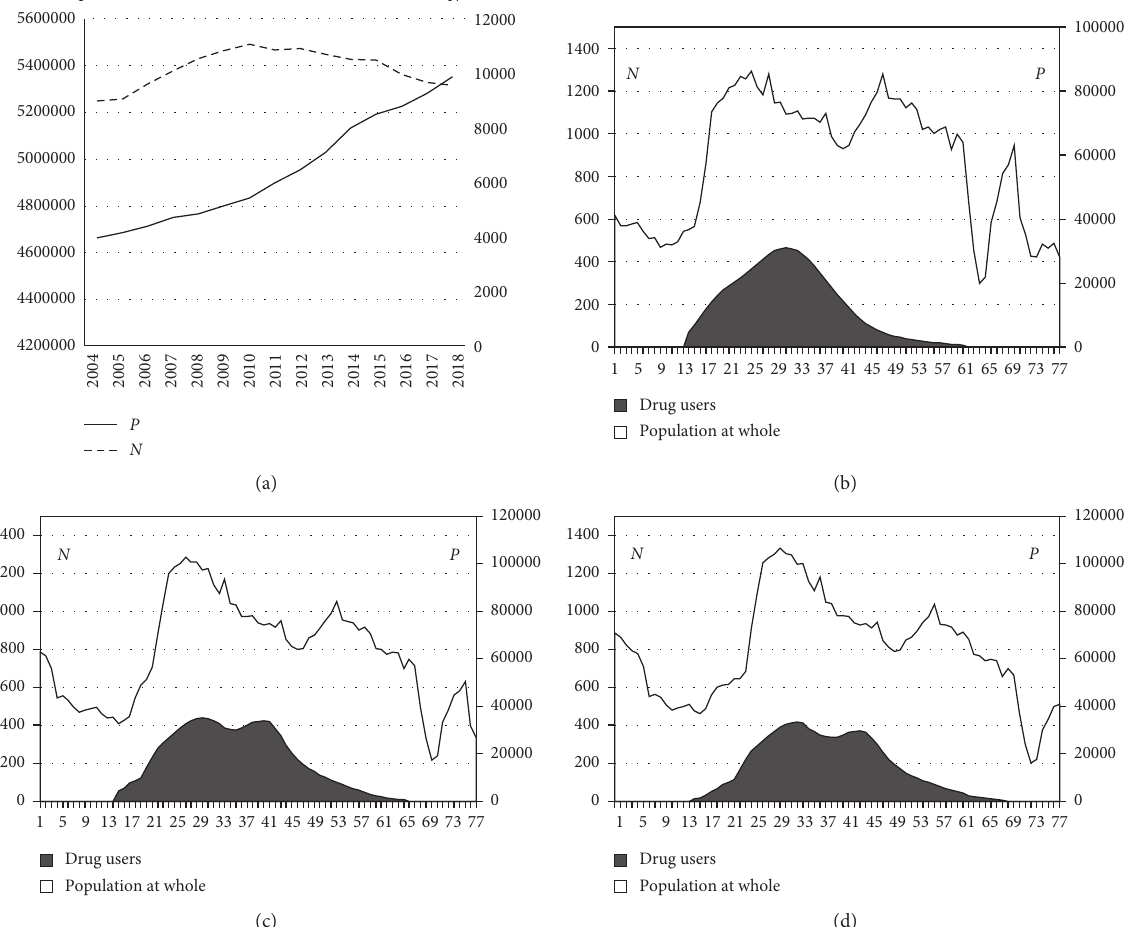
Figure 2: Age structure of the St. Petersburg population: common dynamics of groups P and N ( a ) at whole and in years (b) 2009, (c) 2015, and (d) 2018.